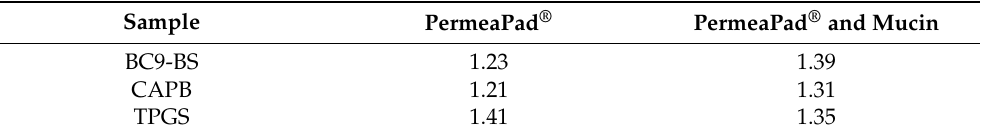
Figure 5. HC permeability across the PermeaPad ® barrier functionalized with a mucin layer in the absence and presence of surfactants at concentrations below (<) and above (>) their CMC. Data are expressed as means ± SD, n = 3. Significance indicated by * = p < 0.05 with respect to Kp of HC without surfactants. Table 1. Enhancement ratio ( ER ) of surfactants employed at a concentration below the CMC using the PermeaPad ® or PermeaPad ® functionalized with a mucin